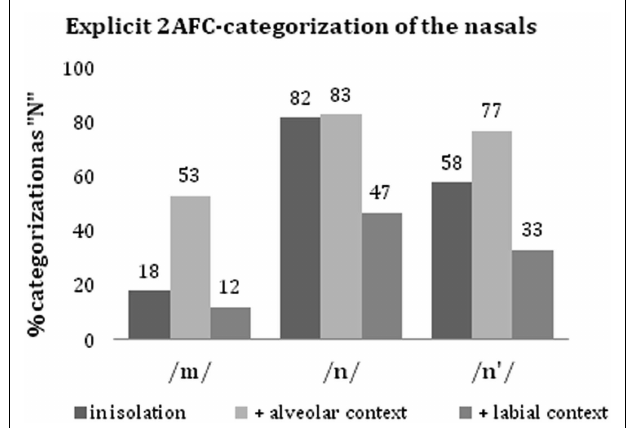
FIGURE 1 | Percentage of nasal-categorization as N in the two-alternative (N or M) forced-choice task. The nasals (/ m /, / n /, and / n (cid:48) /) were presented in isolation, cross-spliced onto a following alveolar (/ d /, / t /), or to a following labial (/ b /, / p /).